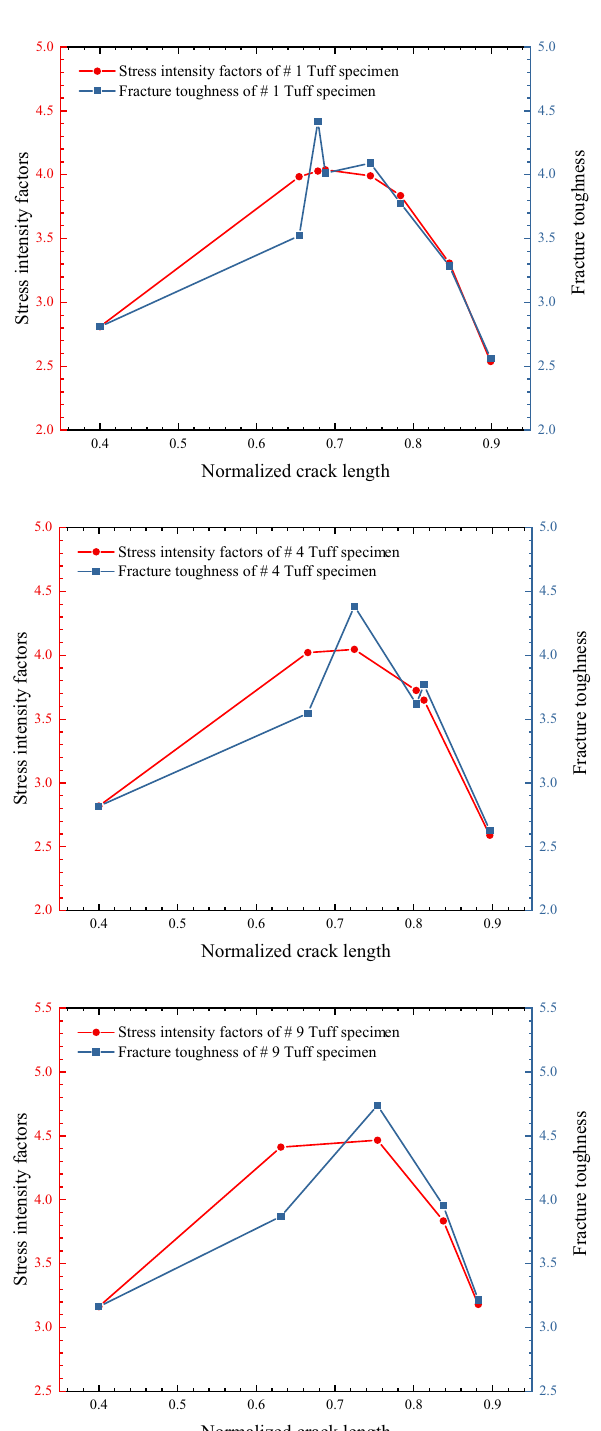
Figure 9. Fracture toughness and stress intensity factor at multiple points of tuff